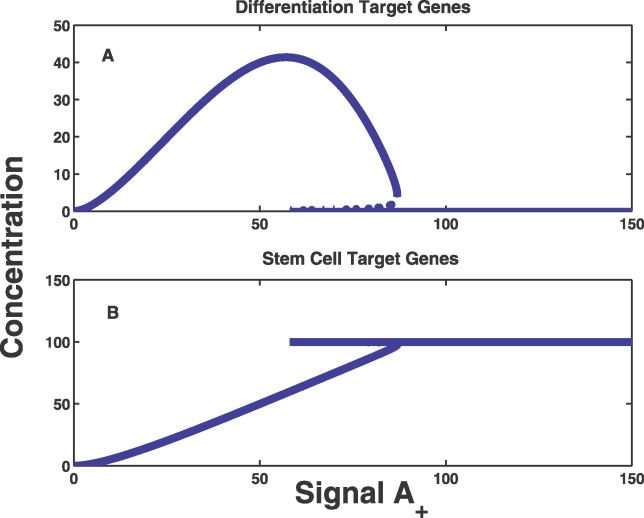
Steady State Values of the TG Expression as a Function of the Input Concentration A
+ for the Differentiation and Stem Cell Genes Using for the Integrated Model with the Incoherent Feedforward Architecture Differentiation TG Expression and Stem Cell TG Expression(A) Differentiation TG expression.(B) Stem cell TG expression.Once the stem cell box is on, the [OS] levels are fixed by the switch: for example, if it is larger than ≈100, the stem cell genes are expressed and the differentiation genes are shut off.